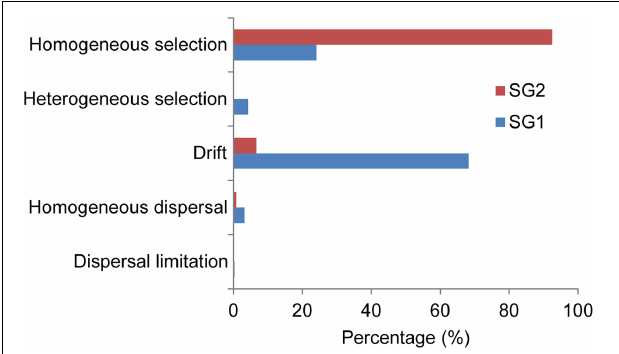
FIGURE 5 | Quantification of the relative roles of ecological processes in archaeal community assembly. The percentage of each assembly process was quantified in SG1 and SG2 using Stegen’s method (Stegen et al., 2013).